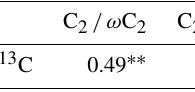
Table 3. Linear correlation coefficients of δ 13 C of C 2 with C 2 /ω C 2 , C 2 / mGly, and TDOC /